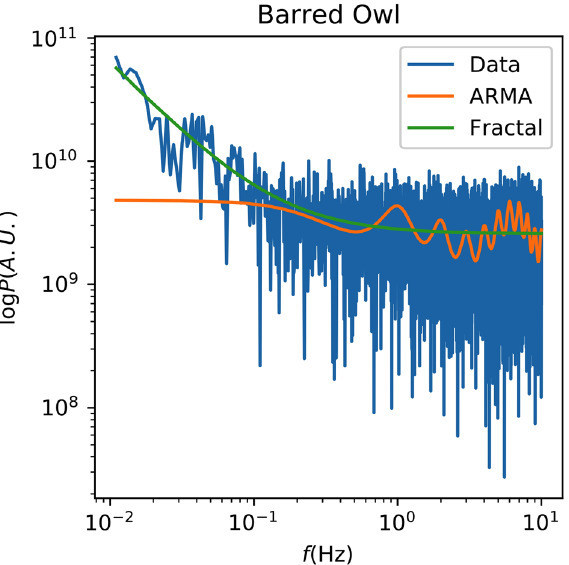
Figure 5. The spectrum of Recording 128,925 of the Barred Owl is shown along with the best-fit ARMA and fractal spectral models.